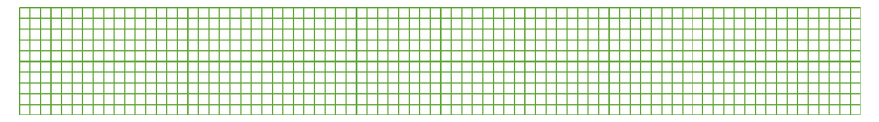
Figure 9: Mesh of the FGPM beam.